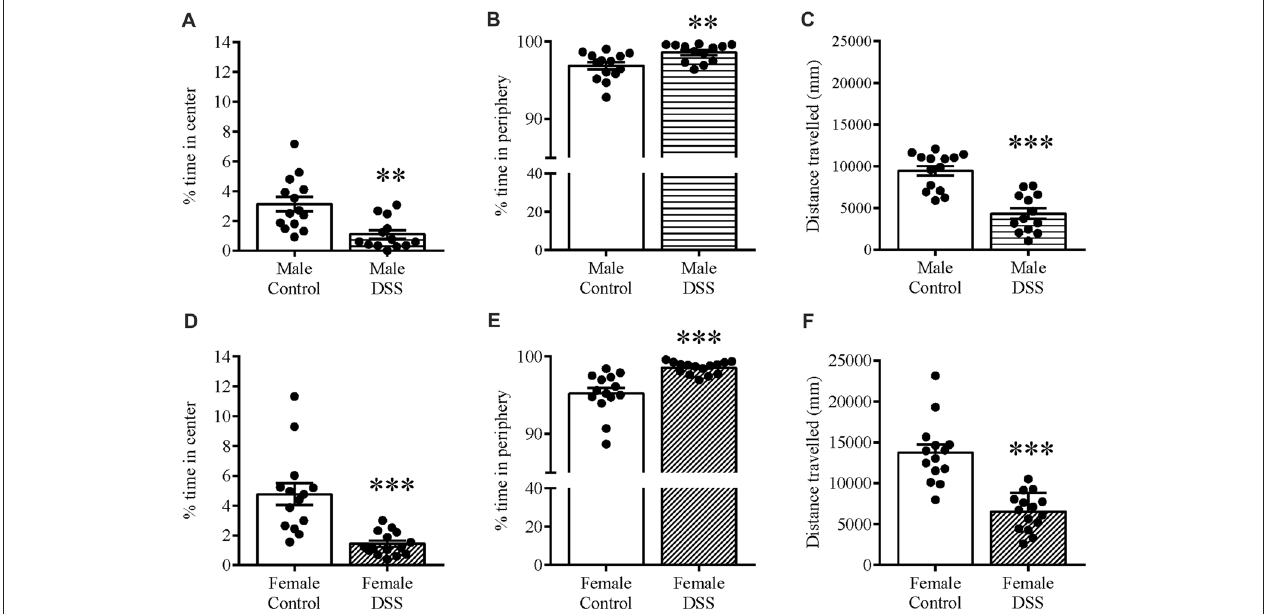
FIGURE 3 | DSS colitis increases anxiety-related behavior and reduces locomotion in the open field (OF). Male and female control/DSS-treated mice, previously tested on the EPM (D7) were subjected to the OF test the next day (D8). In line with previous D7 observations on the EPM, the DSS-induced anxiety-like phenotype remained as indicated by the increased percent time in the peripheral zone of the box (A,D) , and reduced center zone percent time (B,E) in both sexes. The reduced total distance traveled (C,F) was used as a measure of locomotor activity in both males and females. ∗∗∗ P < 0.001, ∗∗ P < 0.01, vs. control mice.